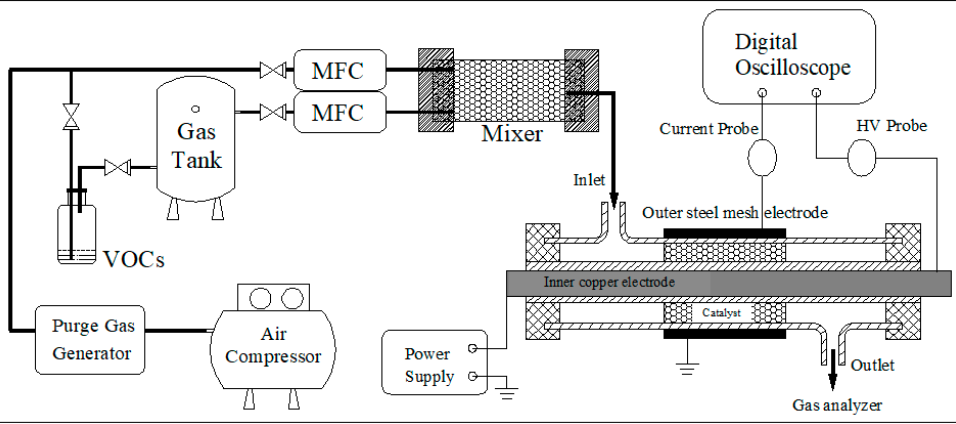
Figure 3. Schematic of plasma catalysis for toluene removal. The DDBD reactor used in the experiment was made up of two coaxial quartz tubes.